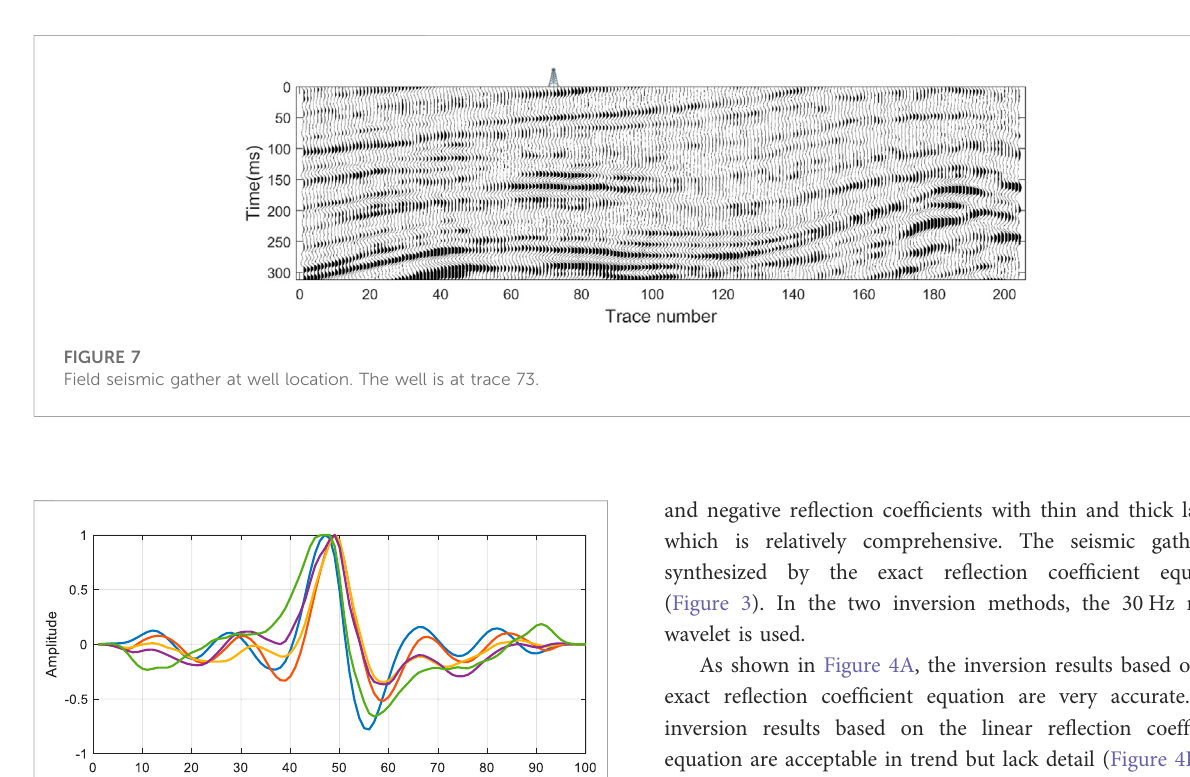
FIGURE 8 Wavelets of different incidence angles. The amplitude is normalized. The corresponding incidence angles are 6 ° (blue), 15 ° (green), 24 ° (orange), 33 ° (purple), and 42 ° (yellow). The smaller the angle of incidence, the larger the amplitude of the wavelets, and vice versa